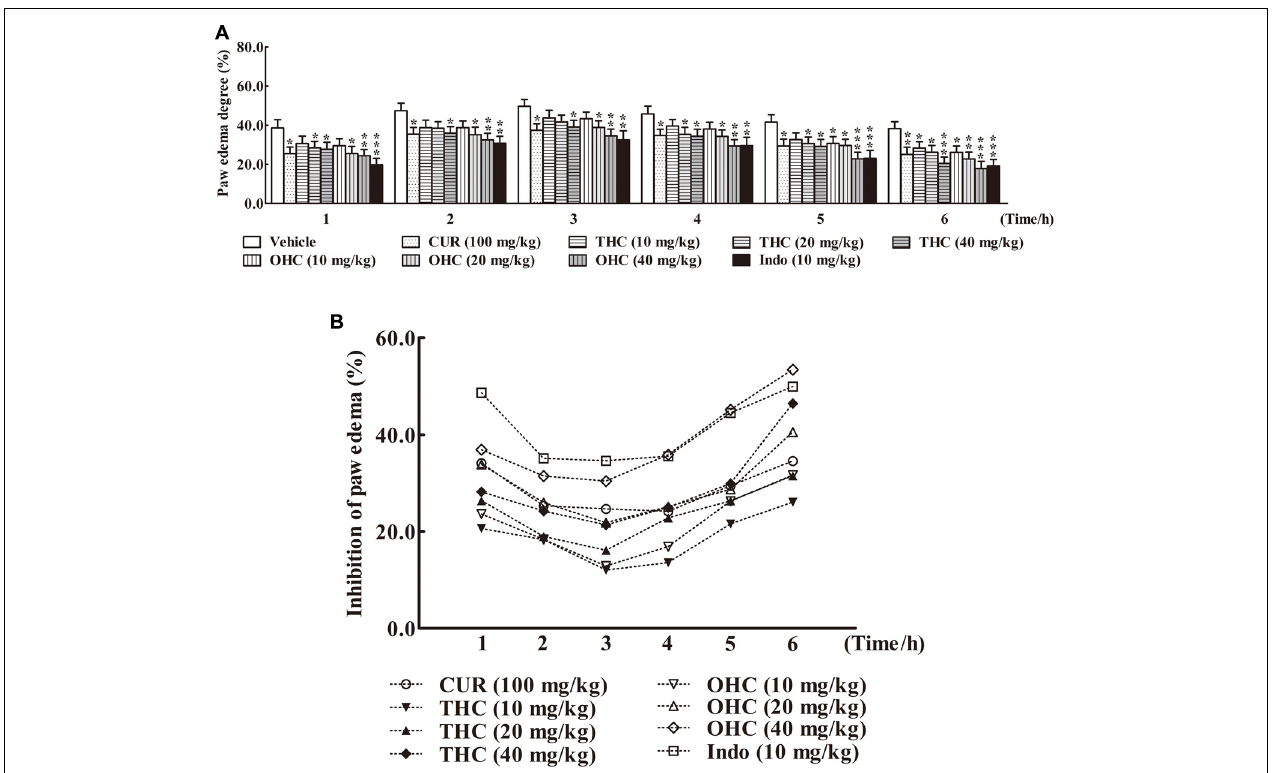
FIGURE 3 | Effects of THC and OHC on the carrageenan-induced paw edema in mice. (A) Paw edema degree was measured using the toes swelling measuring instrument and was represented as the mean ± S.E.M. ( n = 10). (B) Suppression of paw edema (%) was calculated as the ratio of the mean paw size increase of THC and OHC treatment groups (%) over the vehicle control group (%).vs. the vehicle control. Significant differences between groups were determined by ANOVA and Dunnett’s post hoc test. Data were expressed as means ± S.E.M. ( n = 10), ∗ p < 0.05, ∗∗ p < 0.01, ∗∗∗ p < 0.001 vs the vehicle